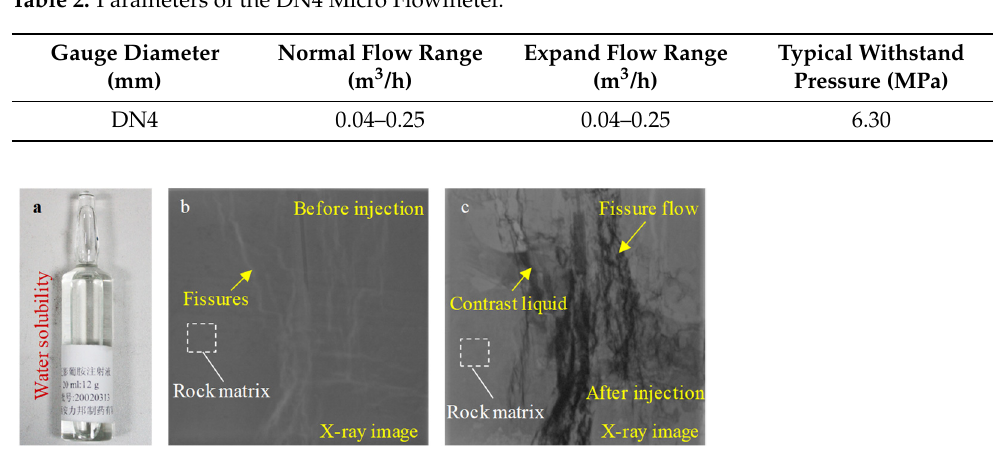
Table 2. Parameters of the DN4 Micro Flowmeter.